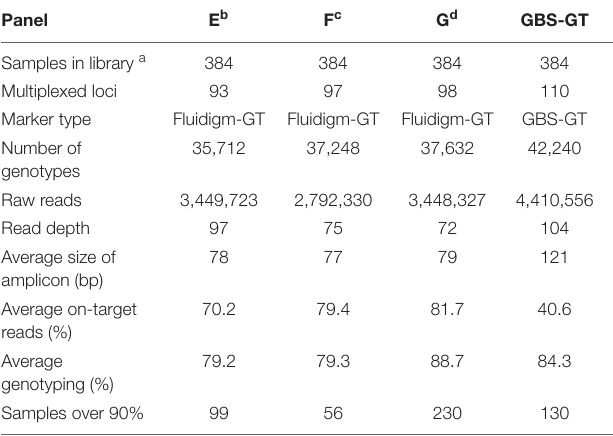
TABLE 4 | Summary of GT-seq results in four panels containing different combinations of multiplexed primers using PrimerPooler. Panel E b F c